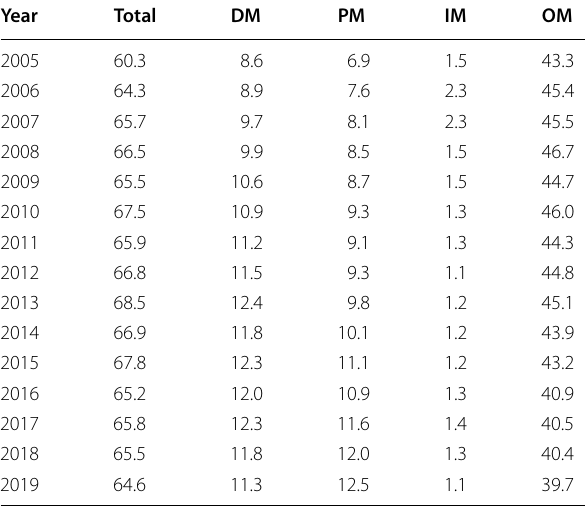
Table 1 Development of the prevalence rates (per 100,000) in